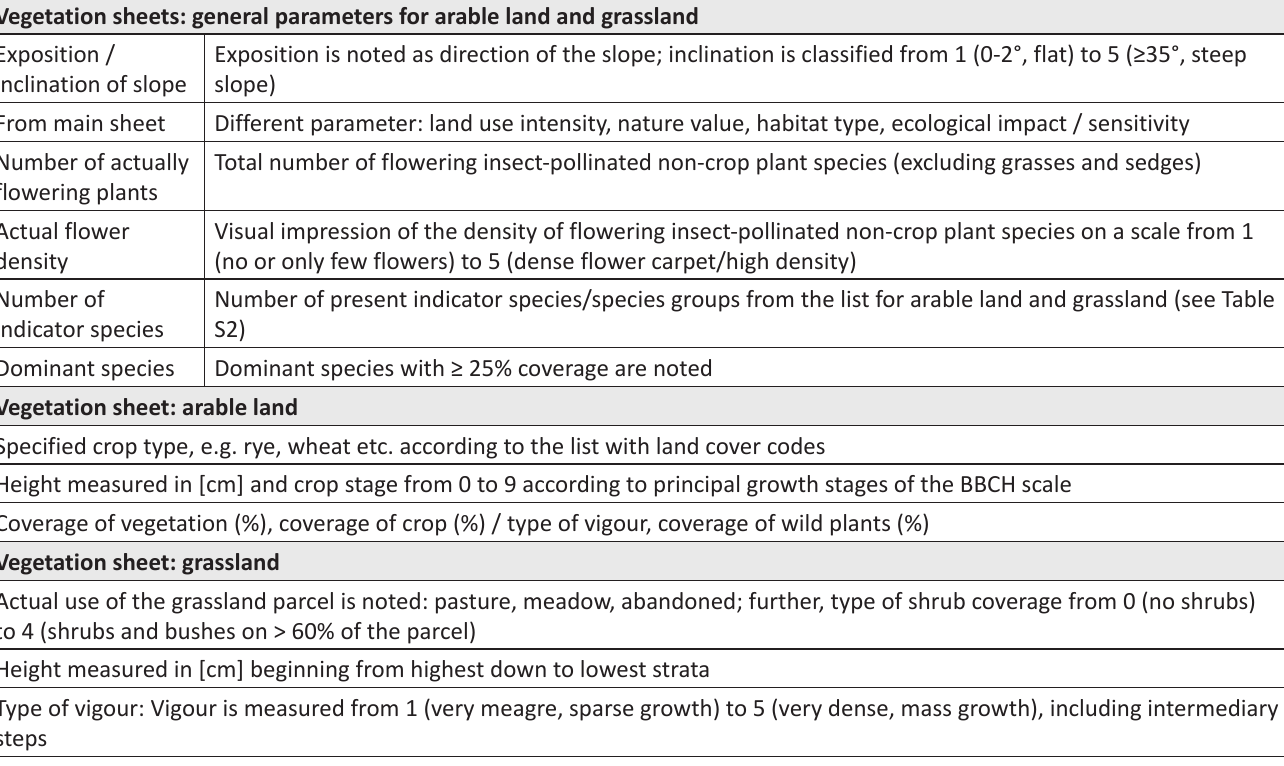
Table 3. Overview of parameters collected in the vegetation